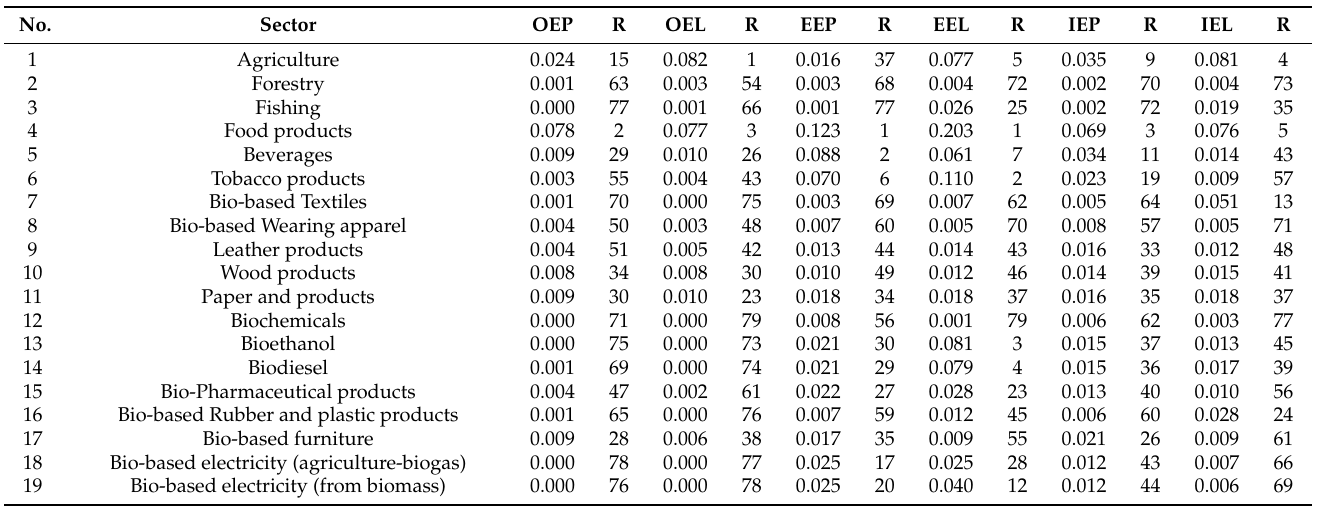
Table 4. Input–output elasticities of the Polish and Lubelskie Region bioeconomy sectors (output, employment, and income).